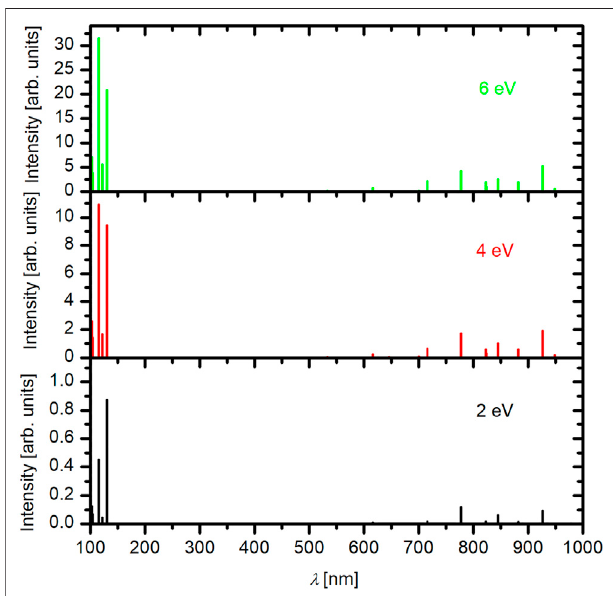
FIGURE 3 | Simulated spectra arising from O-atoms in plasma of electron temperature 2, 4 and 6